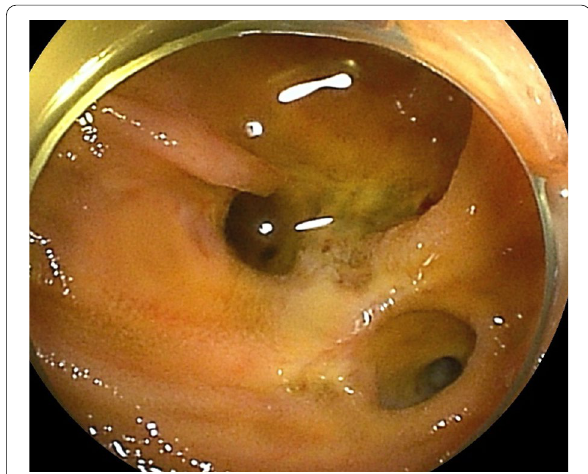
Fig. 5 Findings of double-balloon enteroscopy 1 month after surgery. Capillary and venous dilation of the mucosa near the hepaticojejunostomy site disappeared